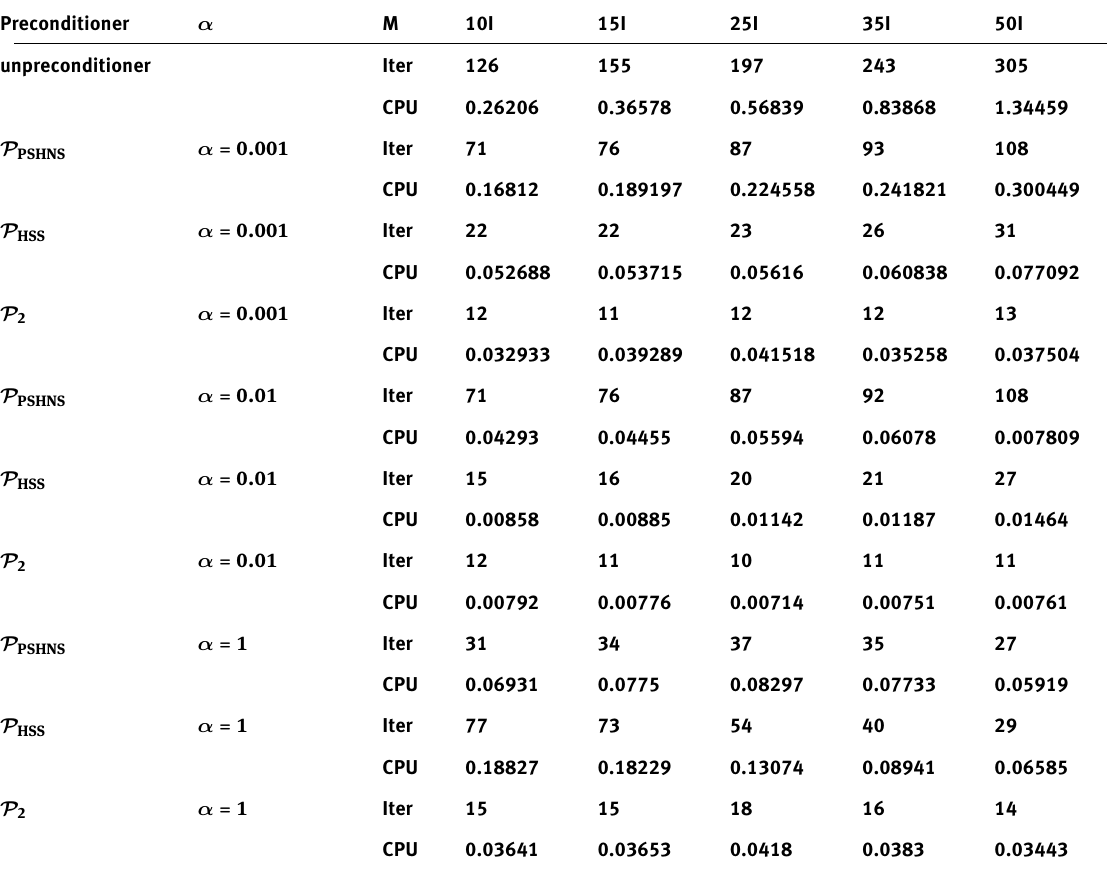
Table 1. Numerical results of GMRES and Preconditioned GMRES methods for Example